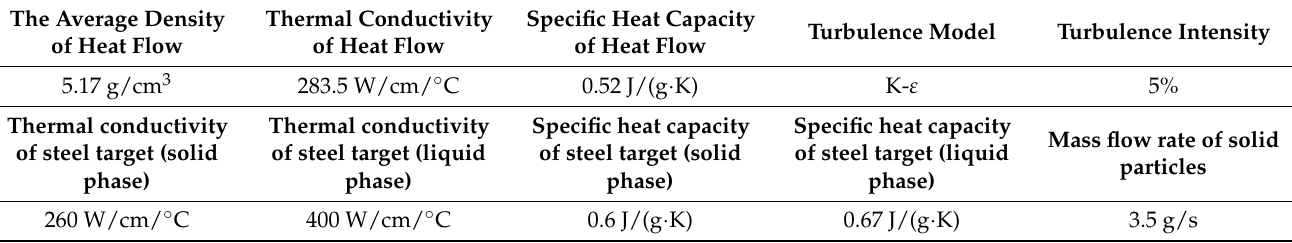
Table 3. Initial conditions for numerical simulation.